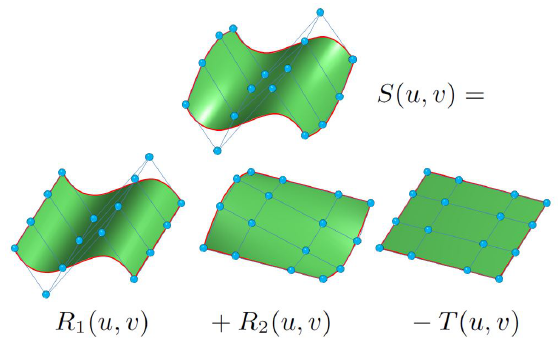
Figure 12. Creation of a bilinear blended Coons surface by R 1 ( u, v ) , R 2 ( u, v ) and T ( u, v